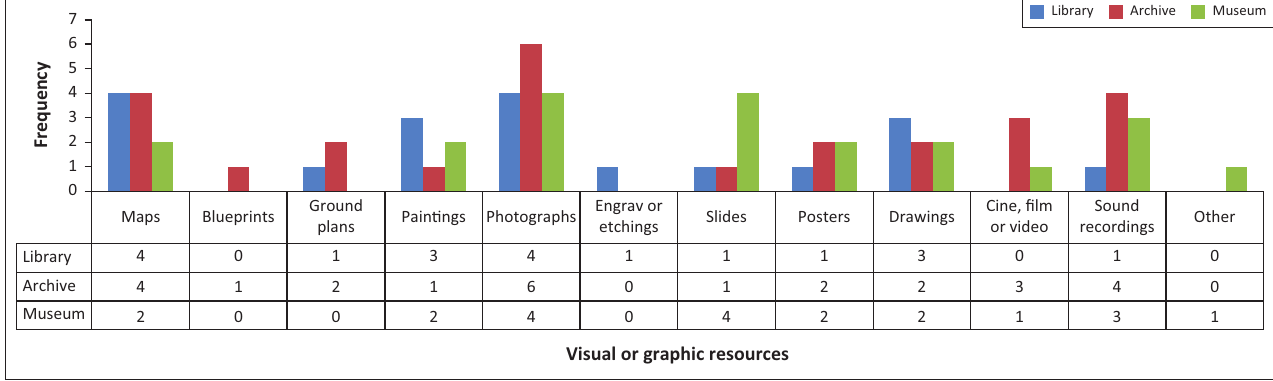
FIGURE 3: Type of visual or graphic and other resources in libraries, archives and museums ( N = 17).